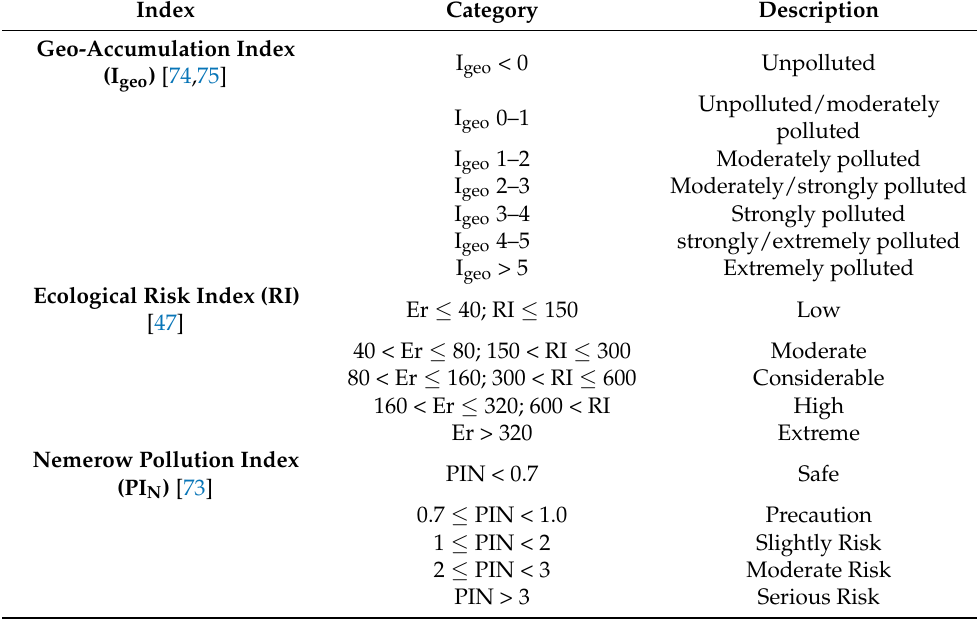
Table 1. Index of